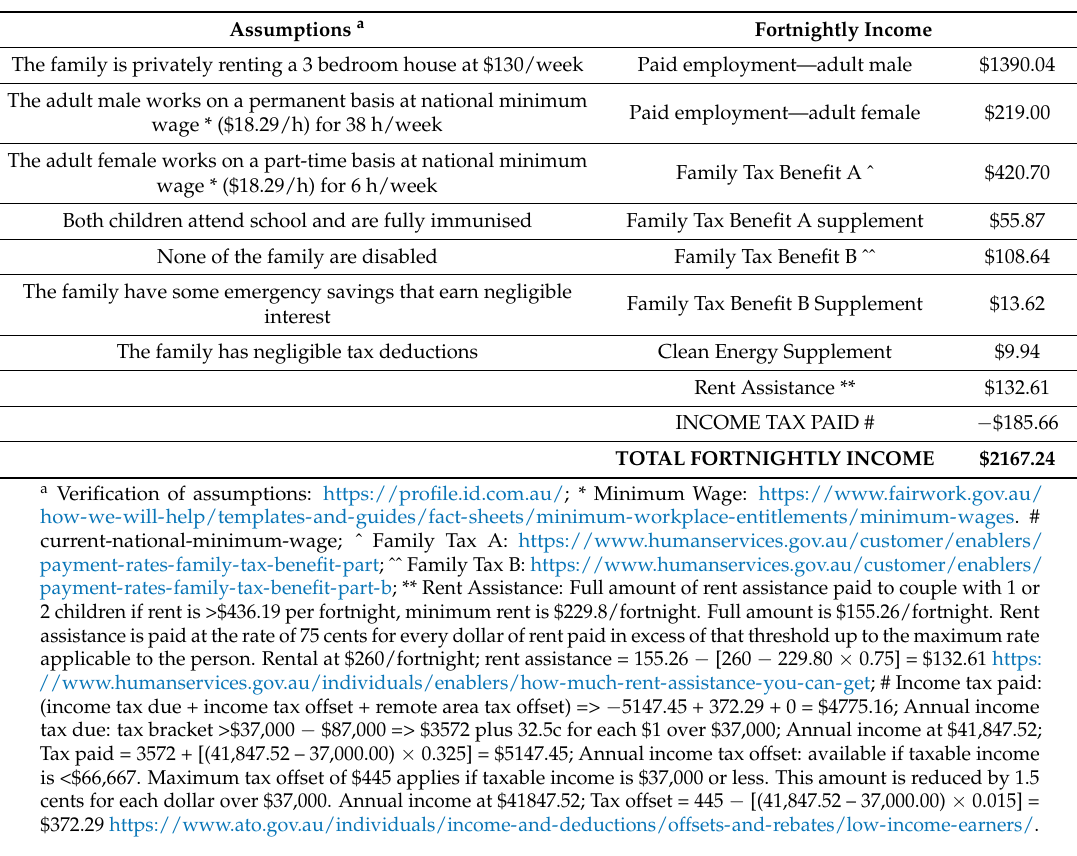
Table 2. Low income household calculations ($AUD) for reference household of two parents with two children within the Local Government Area (adult male; adult female; boy 14 years; girl 8